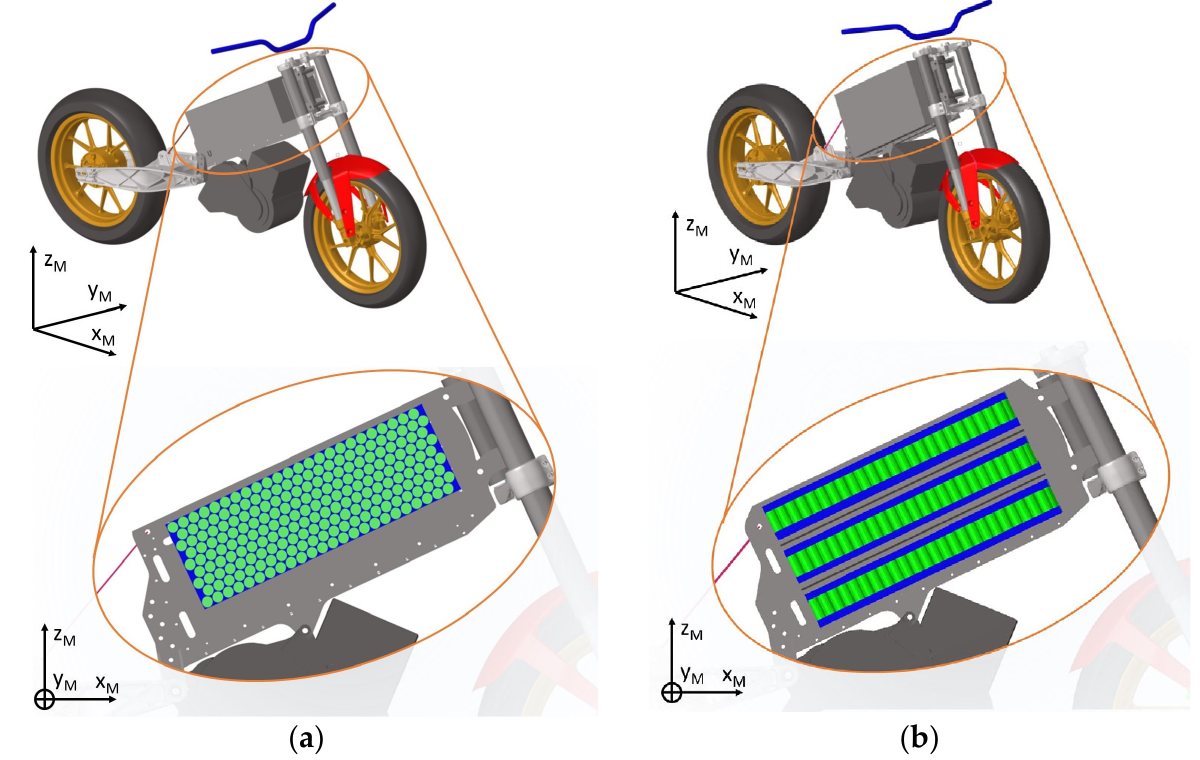
Figure 1. CAD models of the E-PTW with traction ba tt ery: ( a ) Concepts Y and ( b ) Concept Z.